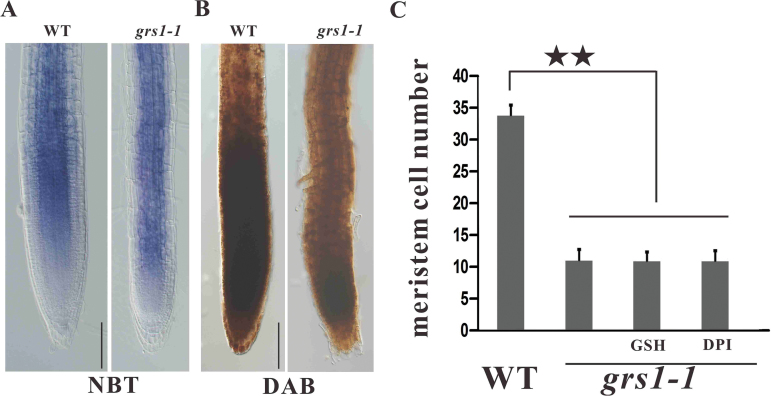
grs1-1 mutants do not accumulate more ROS than the wild-type. (A) Nitroblue tetrazolium (NBT) staining for superoxide in primary root tips of wild-type and grs1-1 plants. (B) 3, 3-diaminobenzidine (DAB) staining for H2O2 in primary root tips of wild-type and grs1-1 plants. Scale bars = 100 µm. (C) Root meristem cell number in wild-type, grs1-1, and grs1-1 with addition of reducing agents glutathione (GSH) or diphenyleneiodonium chloride (DPI). The values obtained were averaged for n>20, with error bars representing SD. Statistically significant differences are indicated: **P<0.01 (Student’s t-test;).